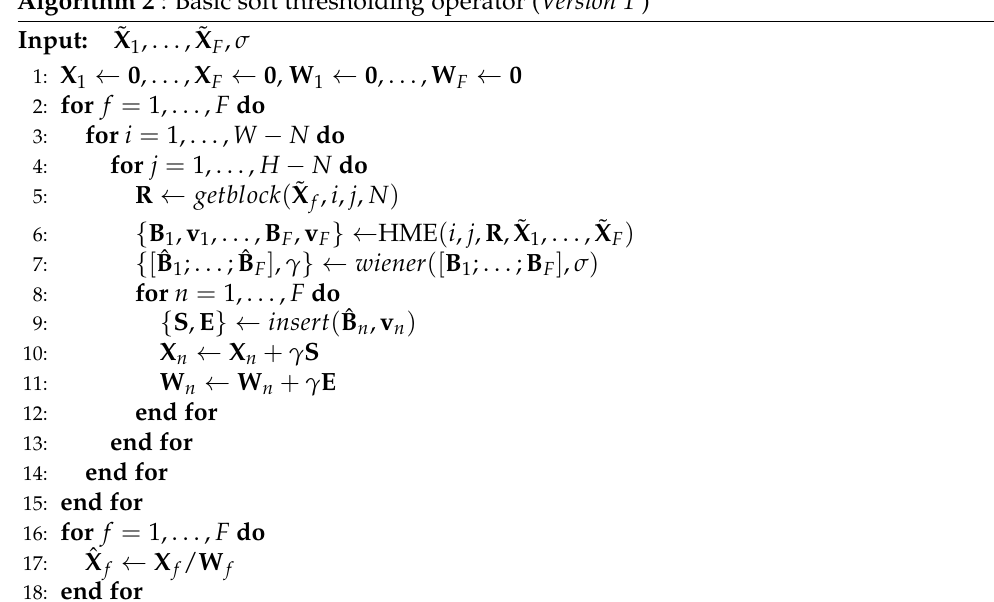
Algorithm 2 : Basic soft thresholding operator ( Version 1